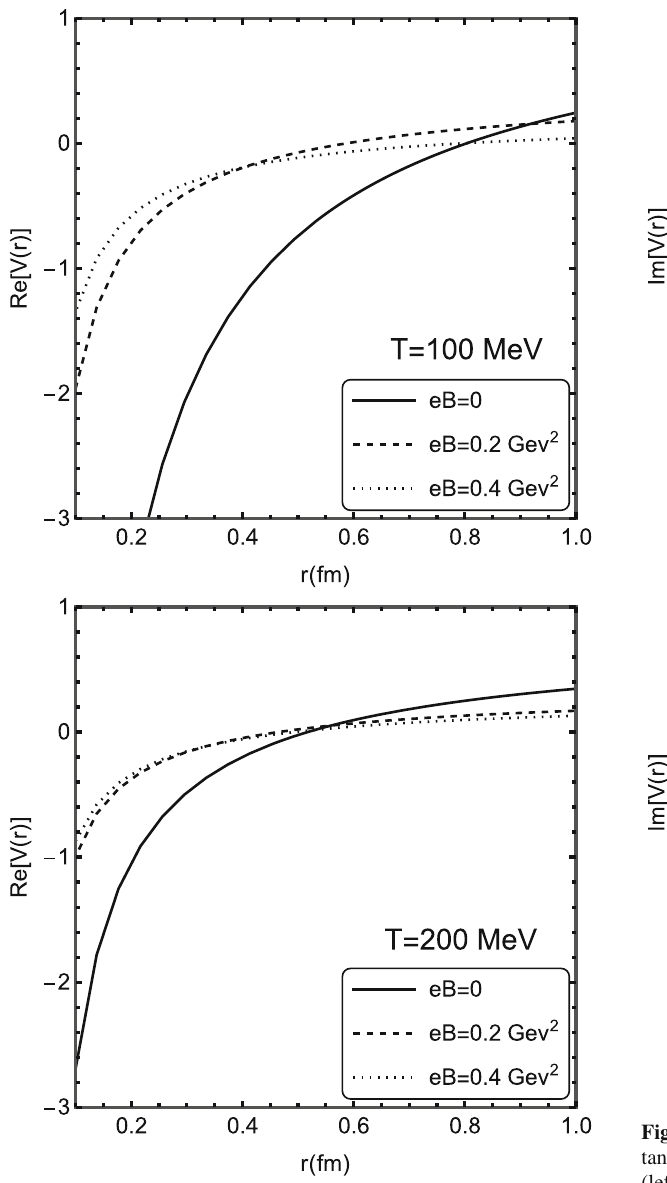
Fig. 3 Variation of the real part of potential with separation distance r between Q ¯ Q for three different values of the magnetic field and with fixed temperature T = 100 MeV (left) and T = 200 MeV (right)